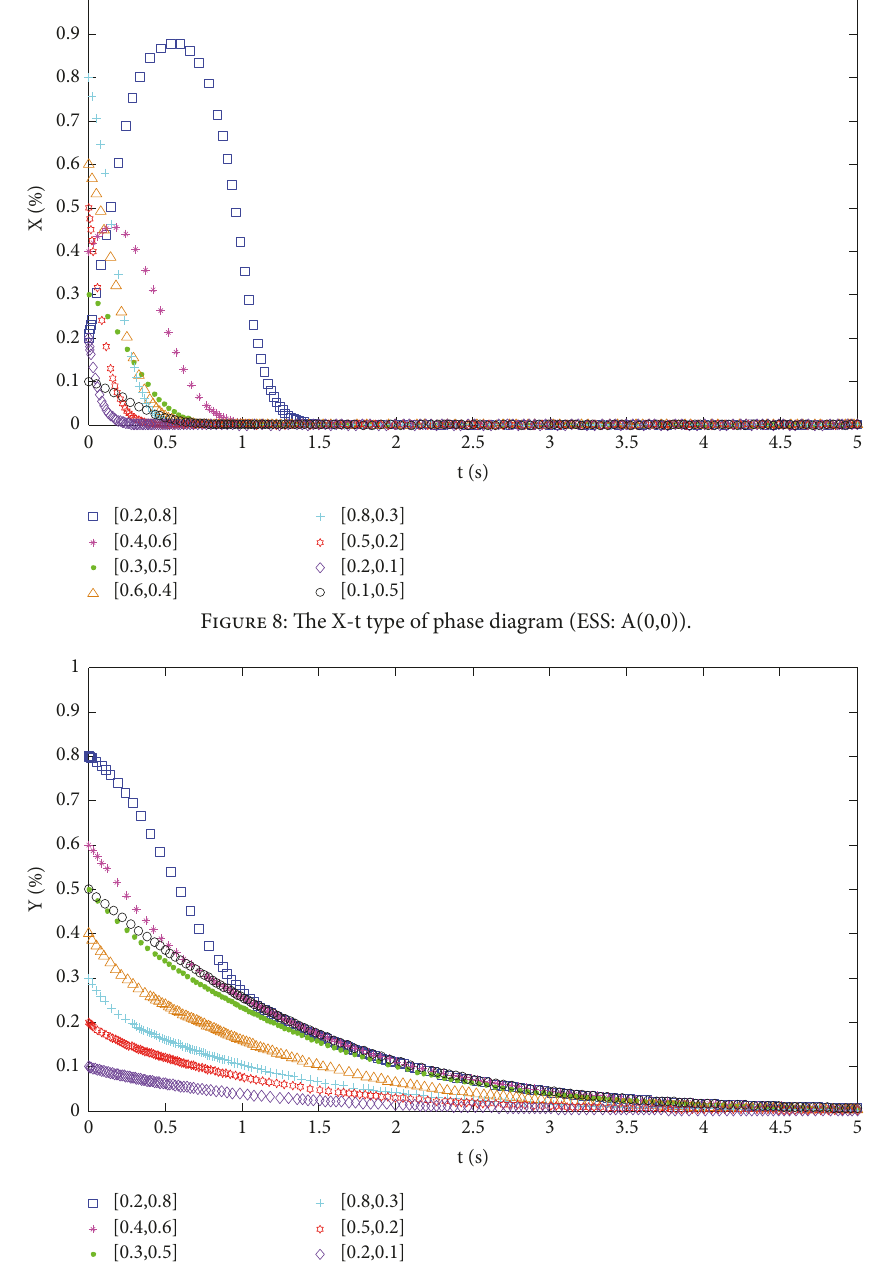
Figure 9: The Y-t type of phase diagram (ESS: